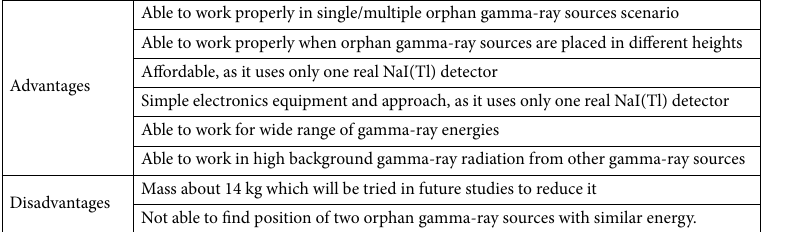
Table 9. The advantages and disadvantages of the gamma finder